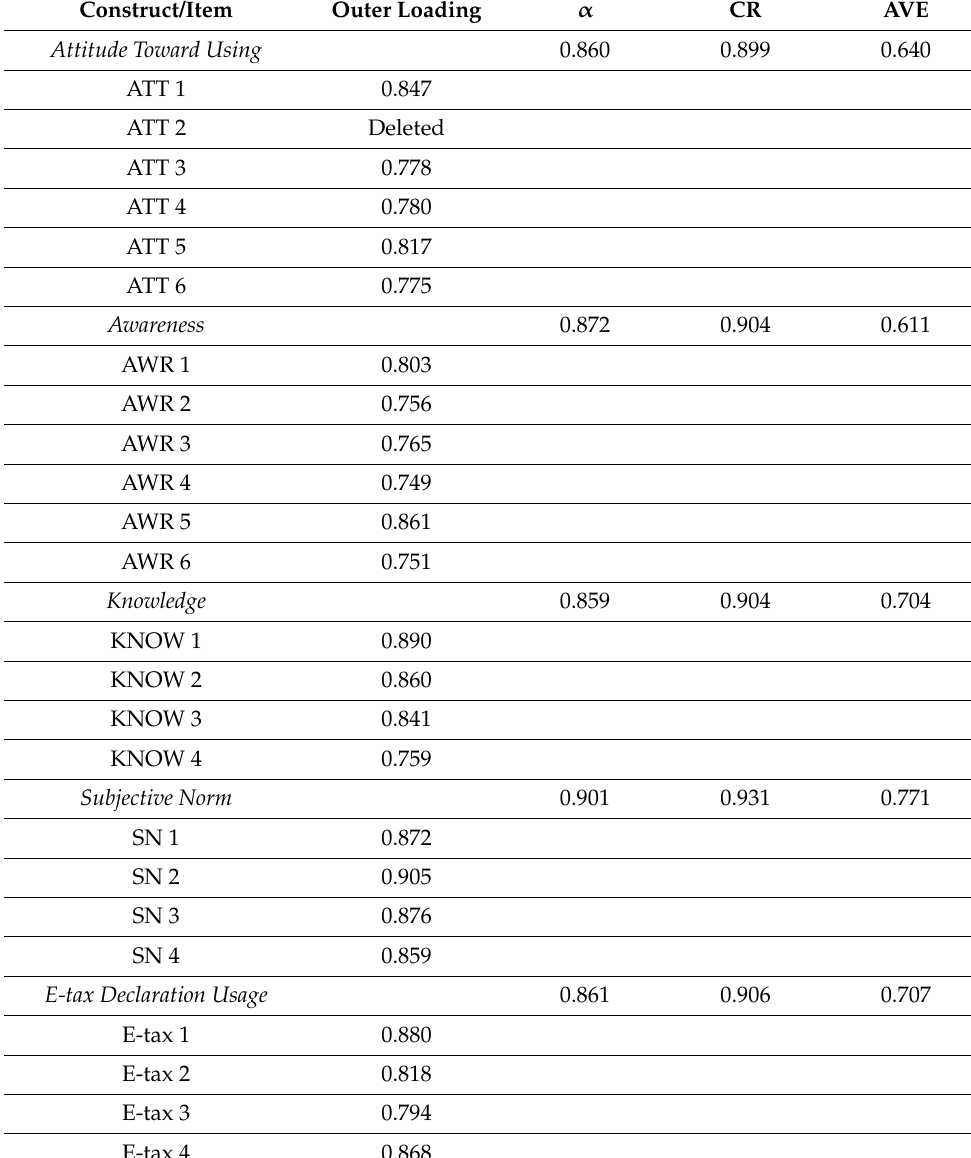
Table 5. Reliability and Convergent